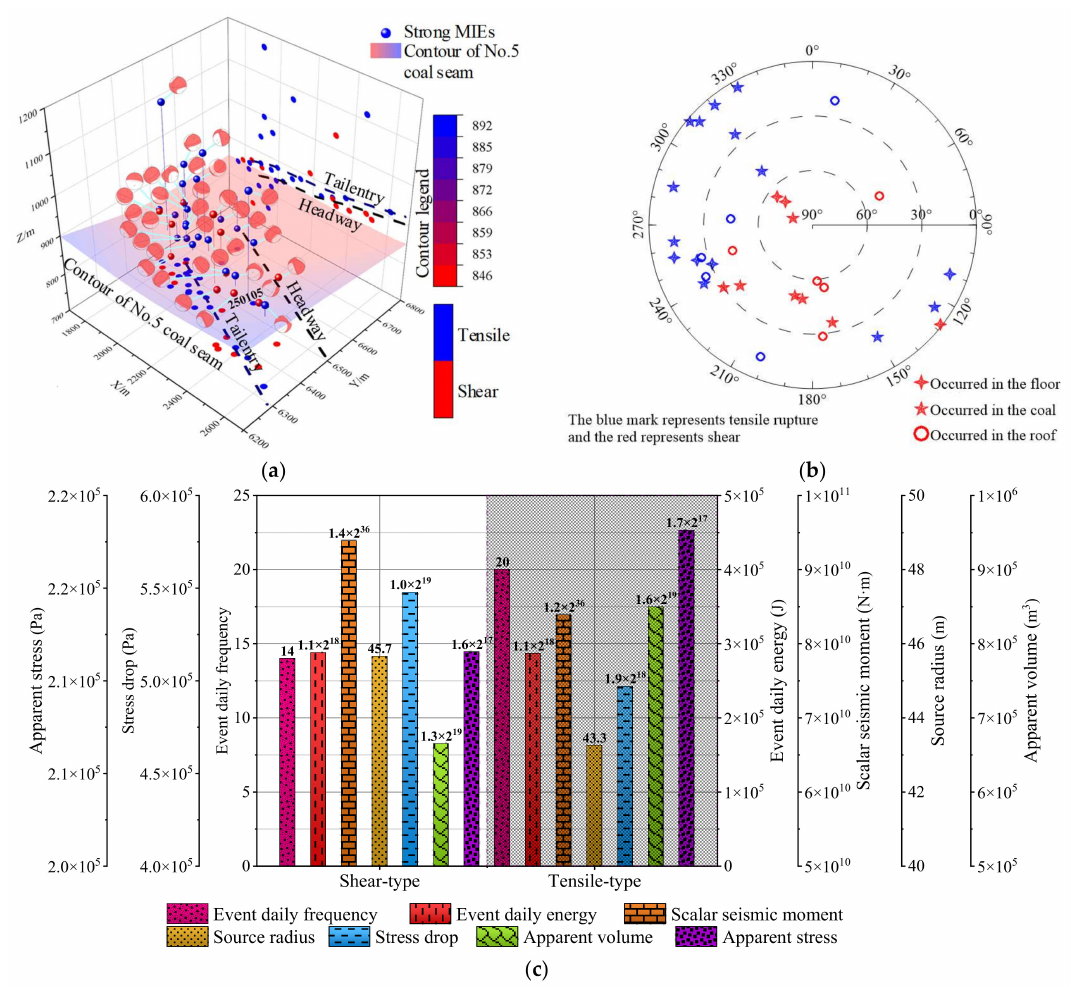
Figure 9. ( a ) Source location and focal mechanism solution of 34 strong MIEs during LW250105 − 1 retreat. ( b ) Source rupture occurrence of 34 strong MIEs. ( c ) Focal mechanism and response character- istics of focal parameters of 34 strong